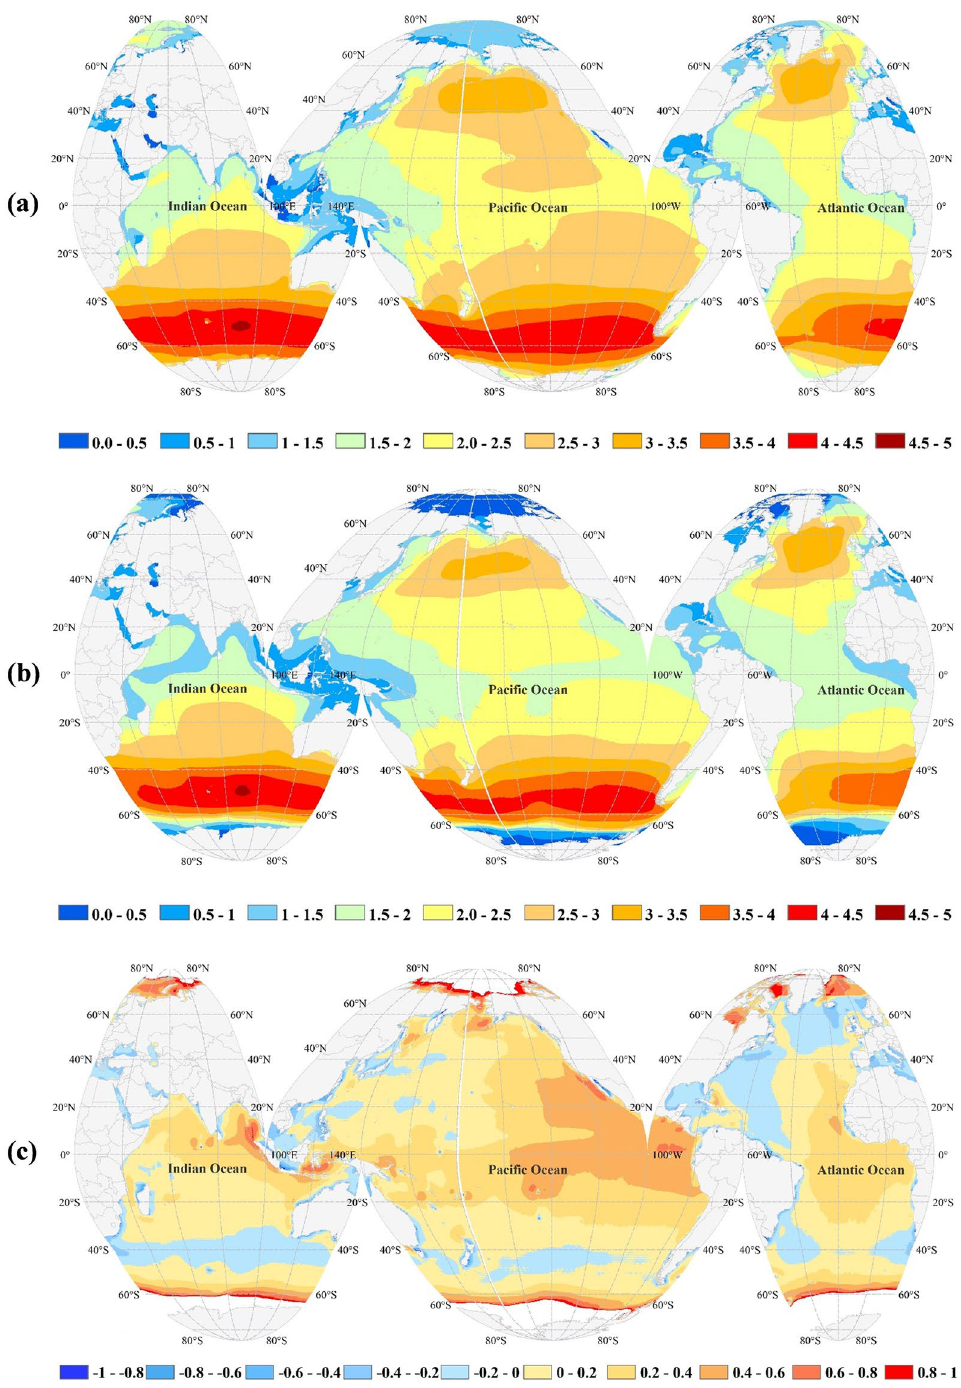
Figure 8. ( a ) mean annual H s (m) based on SWAN output ( b ) mean annual H s (m) based on satellite altimetry, and ( c ) model bias (m). The figure has been generated using ArcGIS 10.2 and Natural Earth-Free vector and raster map data @